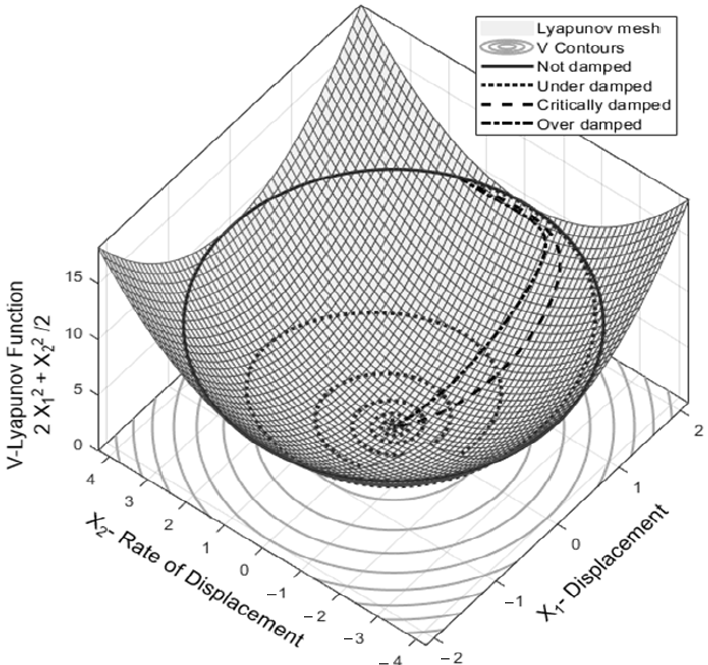
Figure 8. Lyapunov function (V), indicative of global asymptotic stability for the lumped mass dy- namic system (Case example 1) along with the system phase portraits under [2, 1.5] state initial value.